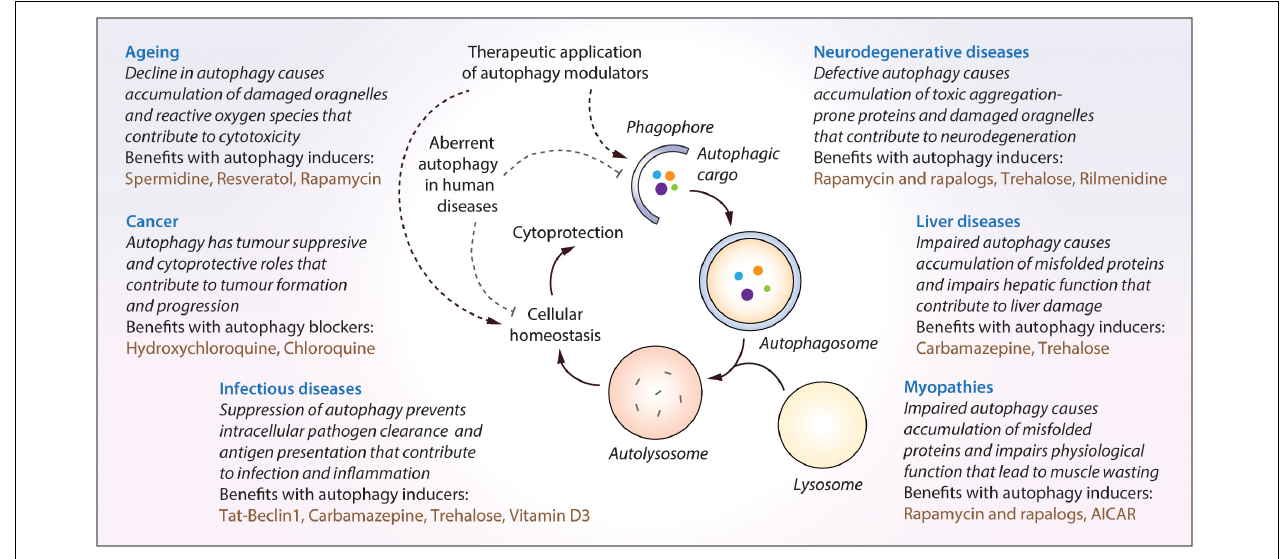
FIGURE 3 | The impact of malfunctioning autophagy and the therapeutic benefits of autophagy modulators in diverse human diseases. Autophagy is implicated in diverse human diseases due to its vital role in maintaining cellular homeostasis. Defective or aberrant autophagy contributes to the cytotoxicity underlying many pathological conditions whereas pharmacological upregulation of autophagy is beneficial in various transgenic models. Key autophagy modulators exerting therapeutic benefits in neurodegenerative disorders, cancer, infectious diseases, liver diseases, myopathies and lifespan extension, as well as the impact of malfunctioning autophagy in these contexts, are